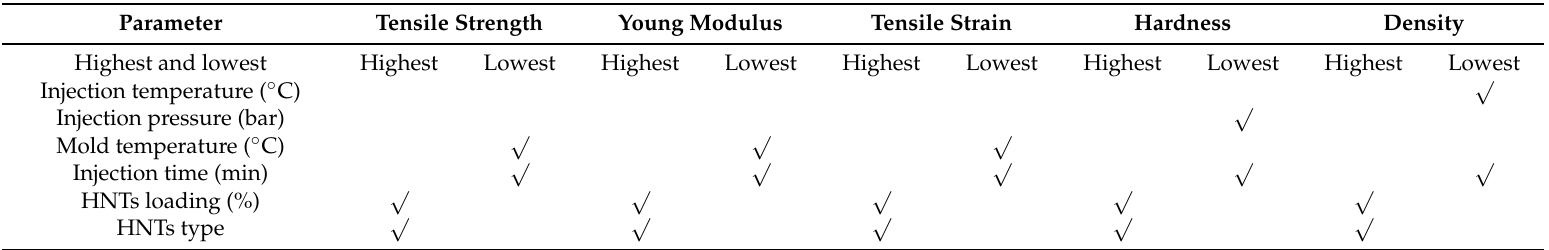
Table 6. The highest and lowest effect of control parameters on